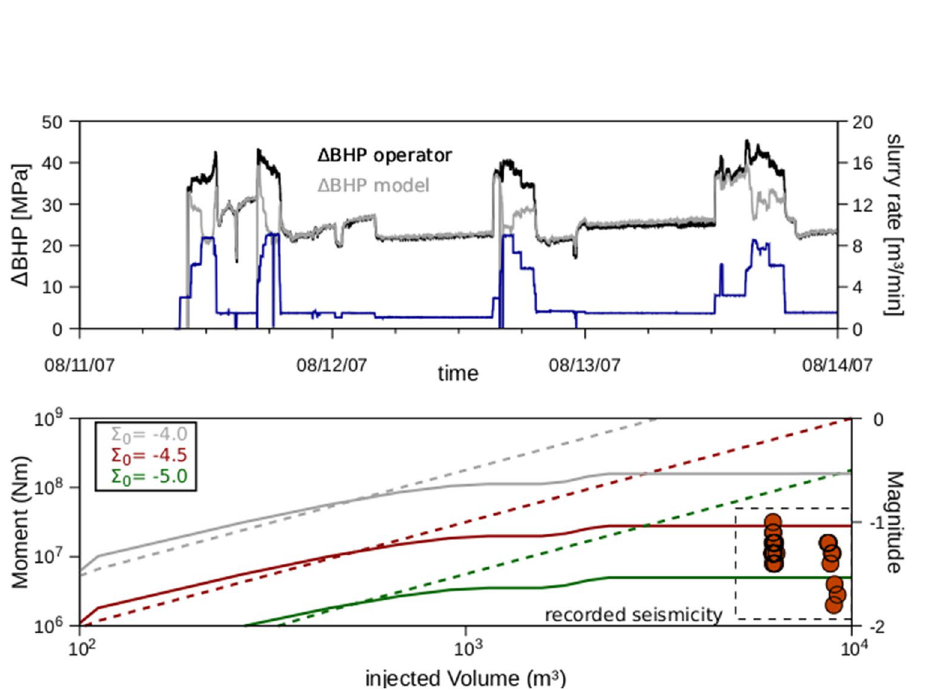
Figure 5. Modelling the 2007 reservoir treatment at Groß Schönebeck 22 . Upper Panel: imposed injection rates (blue curve) as well as measured (black curve) and computed (grey curve) bottom-hole overpressure ( (cid:31) BHP ) for the 2007 stimulation experiment carried out in Groß Schönebeck. Lower panel: predicted (continuous curves) maximum magnitudes and seismic moment as a function of the total injected volume. Dashed curves are predictions derived from Eq. (14) in 10 for different values of the tectonic seismogenic index ( (cid:31) 0 ) that are considered reasonable for the Groß Schönebeck site 26 . The dashed rectangle encloses the recorded micro-